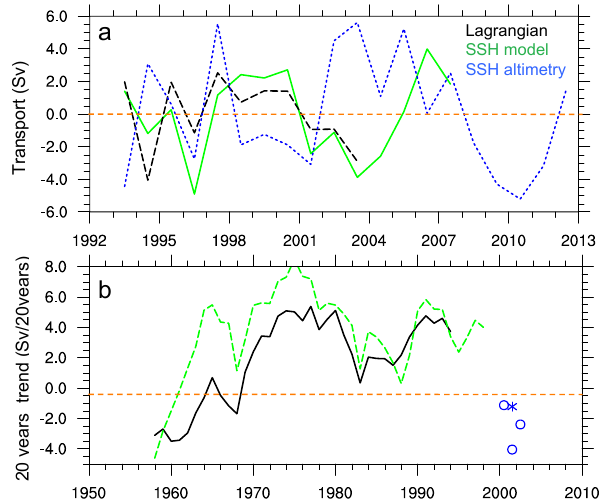
Figure 9. (a) Comparison of leakage anomaly computed from model output using the Lagrangian parcels (black) and the SSH method (green) and from satellite altimetry using the SSH method (blue) along track 20. (b) The 20-year trend (Sv per 20 years) from the same methods as (a) . The blue star is obtained from the 20 years of altimetry data and blue circles in are a sensitivity analysis of the trend computed over 18 years between 1993–2010, 1994–2011 and